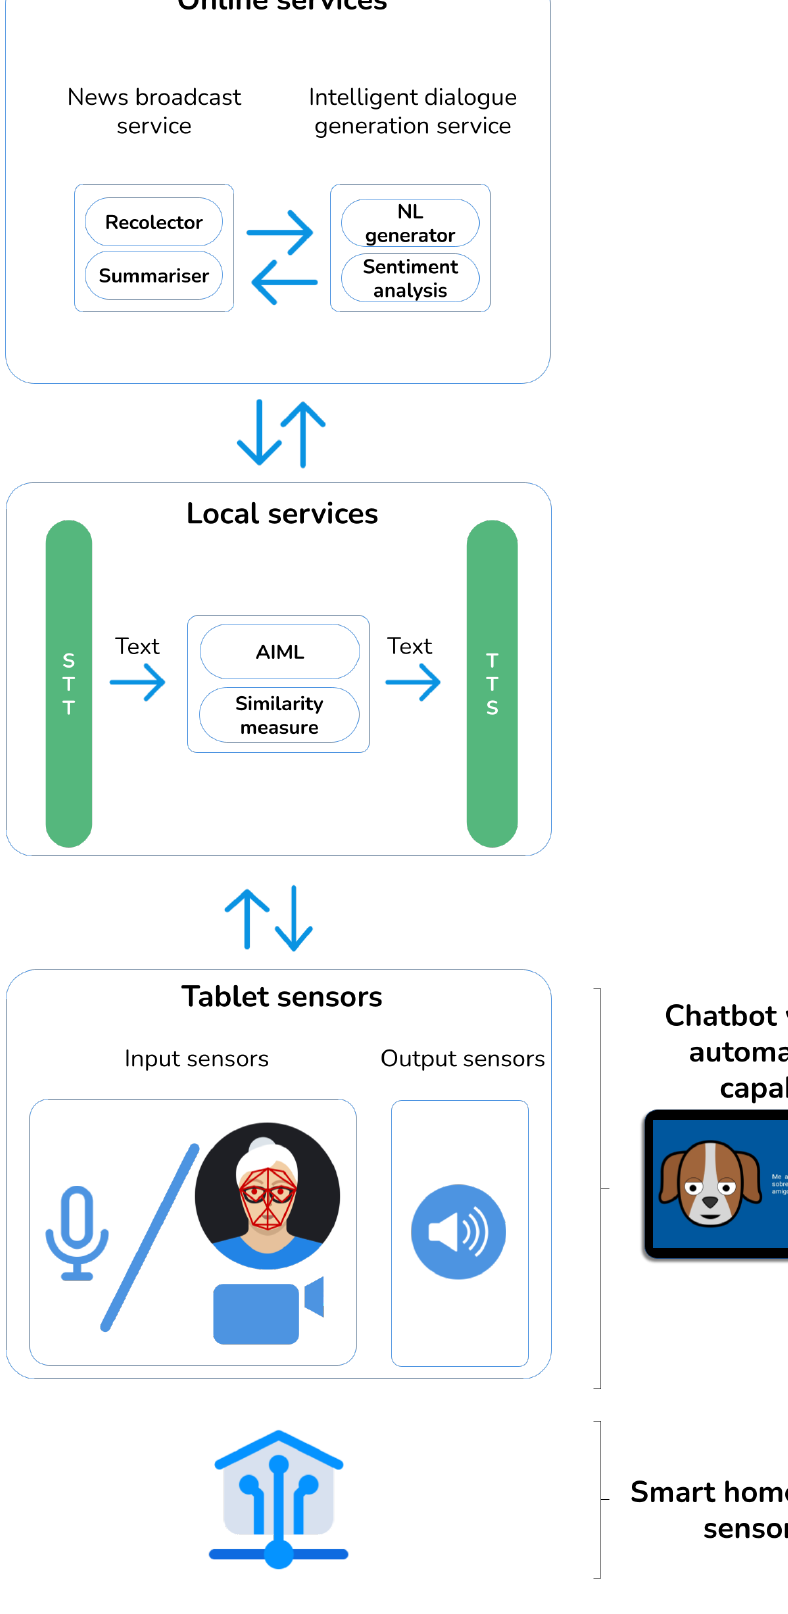
Figure 1. System architecture. STT: speech-to-text conversion, TTS: text-to-speech